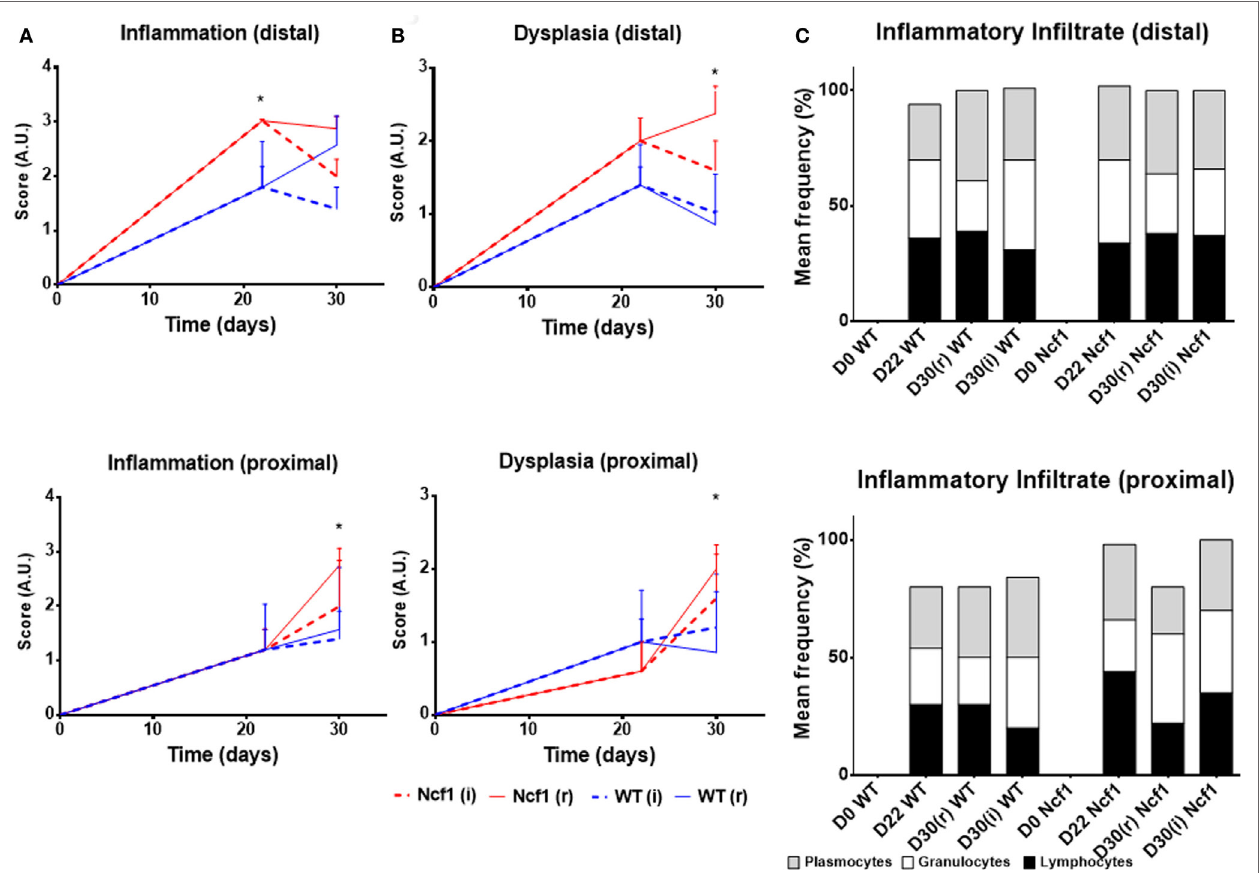
FigUre 3 | Histological evaluation of inflammation (a) , dysplasia (B) , and cellular composition of the inflammatory infiltrate (c) at distal and proximal segments of the colon for Ncf1-mutant (Ncf1)* mice, and WT mice. Asterisks indicate p < 0.05, Mann–Whitney U test between Ncf1(r) and WT (r) and Ncf1(i) and WT(i). Inflammation and dysplasia scoring systems are detailed in Section “Materials and